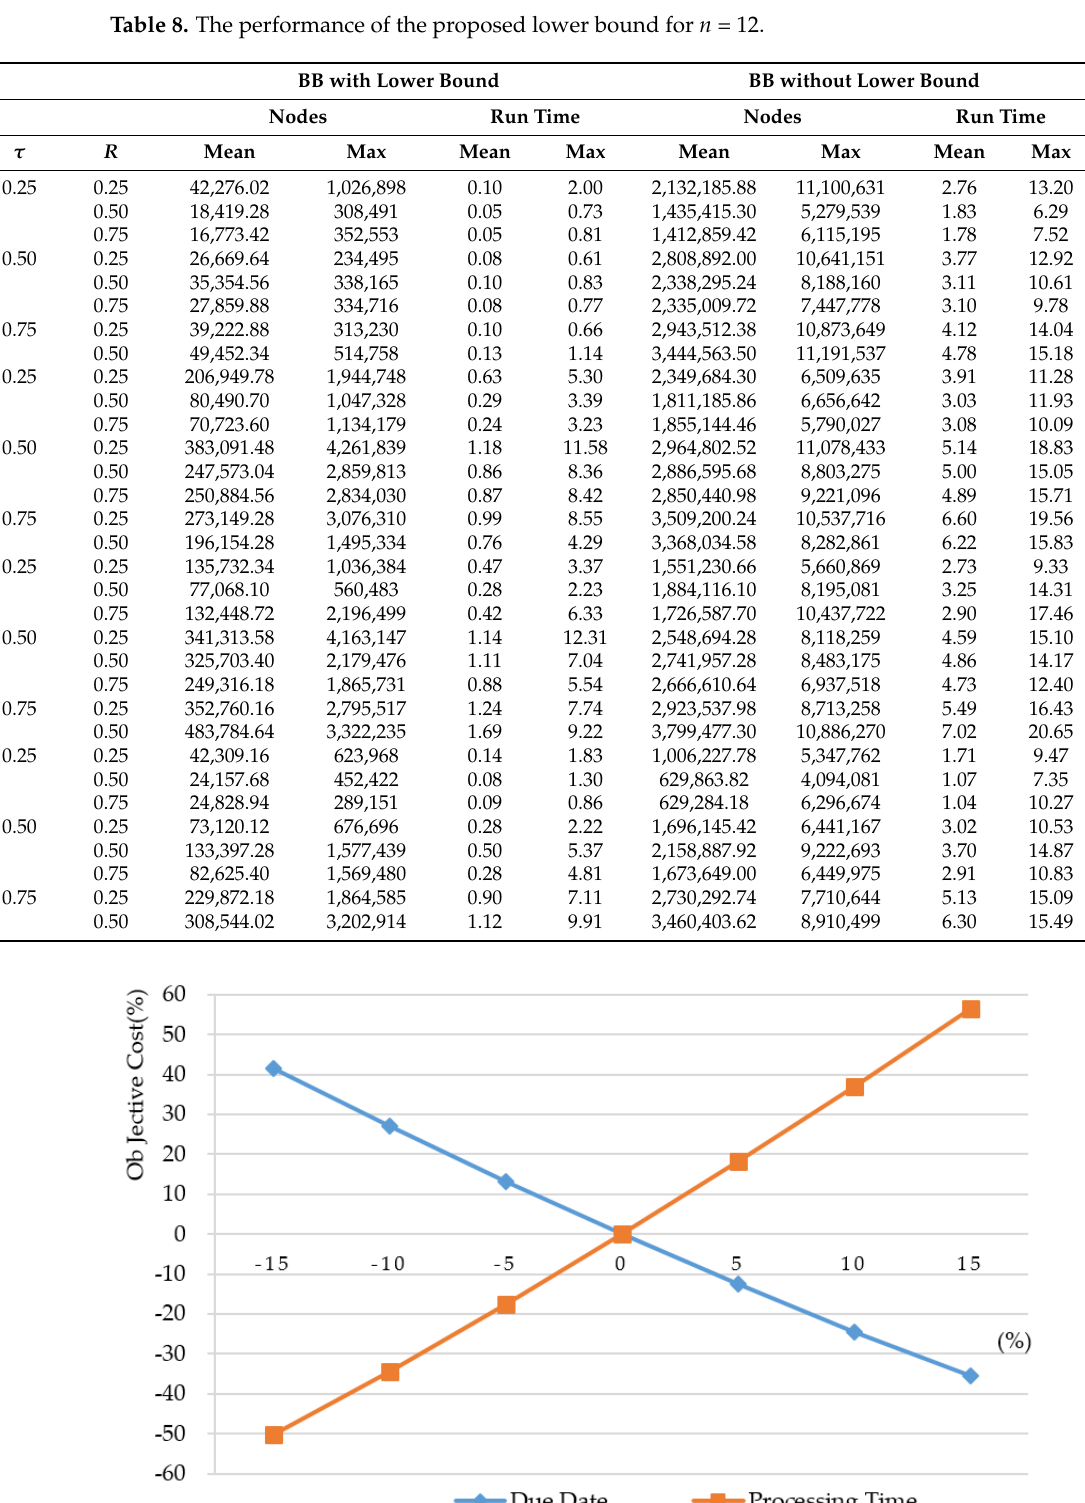
Figure 5. The influence of